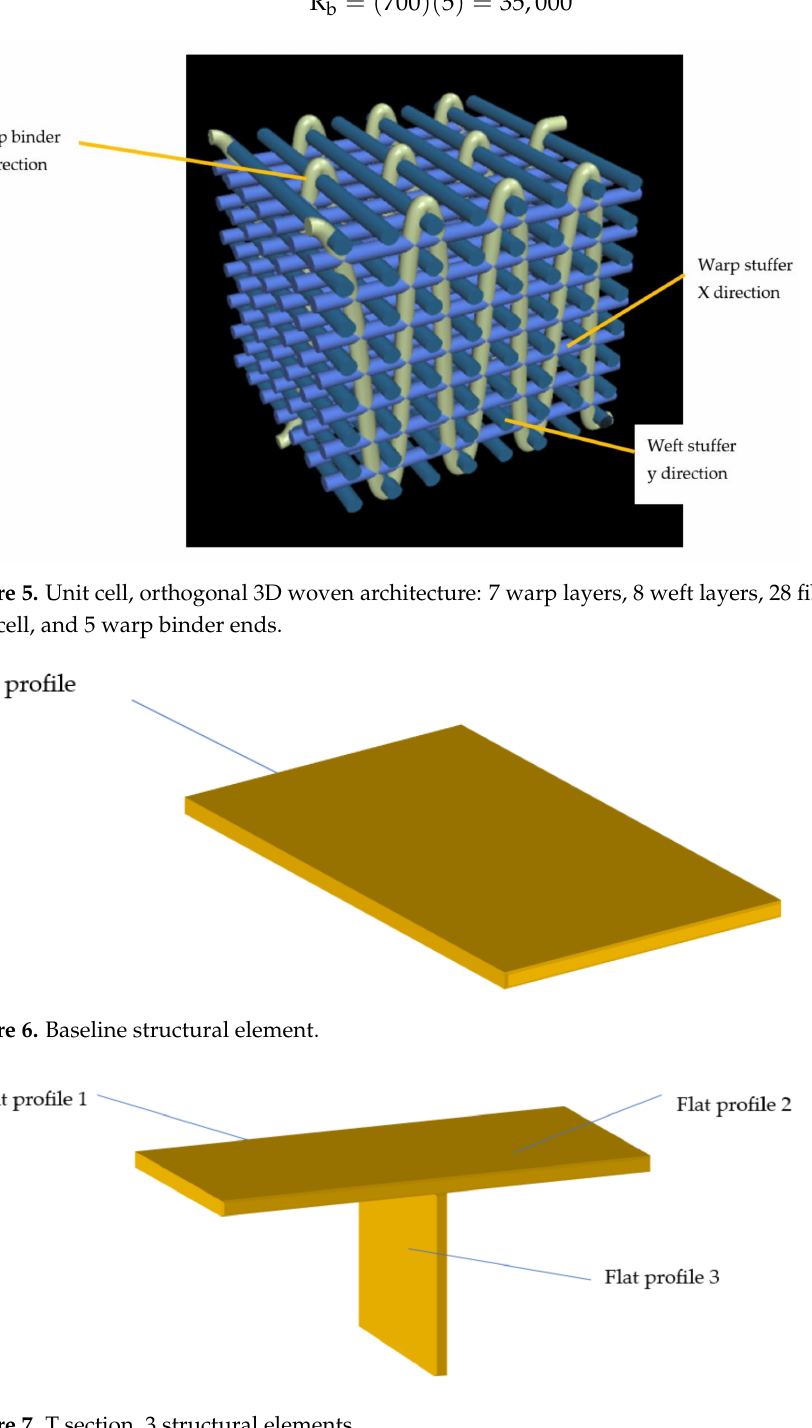
Figure 7. T section, 3 structural elements.